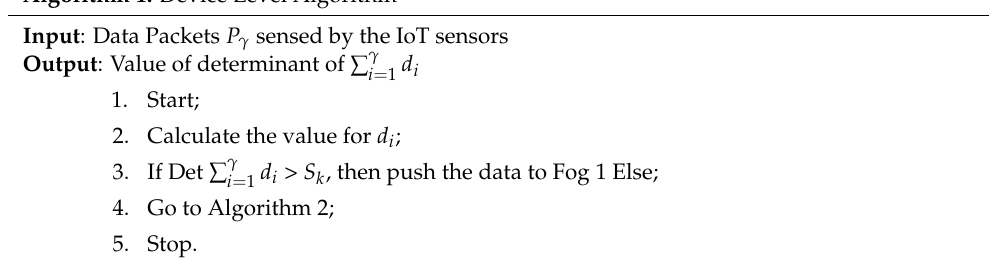
Algorithm 1: Device Level Algorithm